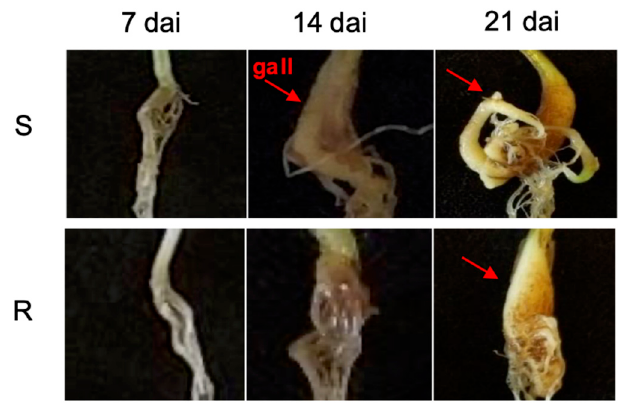
Figure 1. Phenotypes of Plasmodiophora brassicae -inoculated roots of the rutabagas ‘Wilhelmsburger’ (R) and ‘Laurentian’ (S) at 7, 14, and 21 days after inoculation (dai). A red arrow indicates the presence of galls.